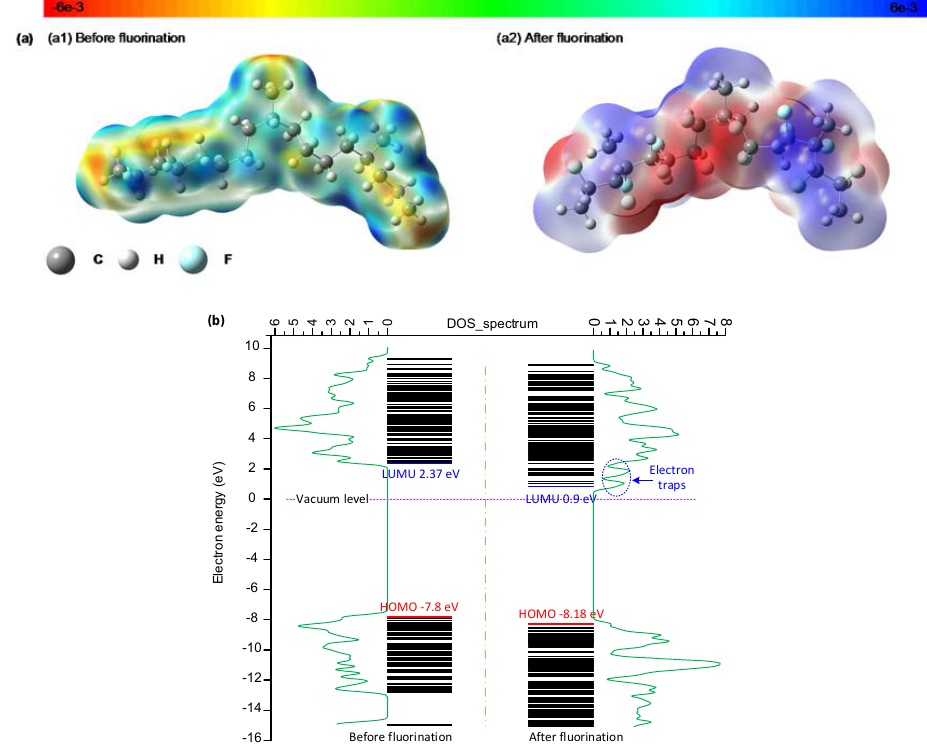
Figure 9. ( a ) 3D potential distribution of the EPDM surface layer before and after fluorination; ( b ) density of states (DOS) and energy level of the EPDM surface layer before and after fluorination.